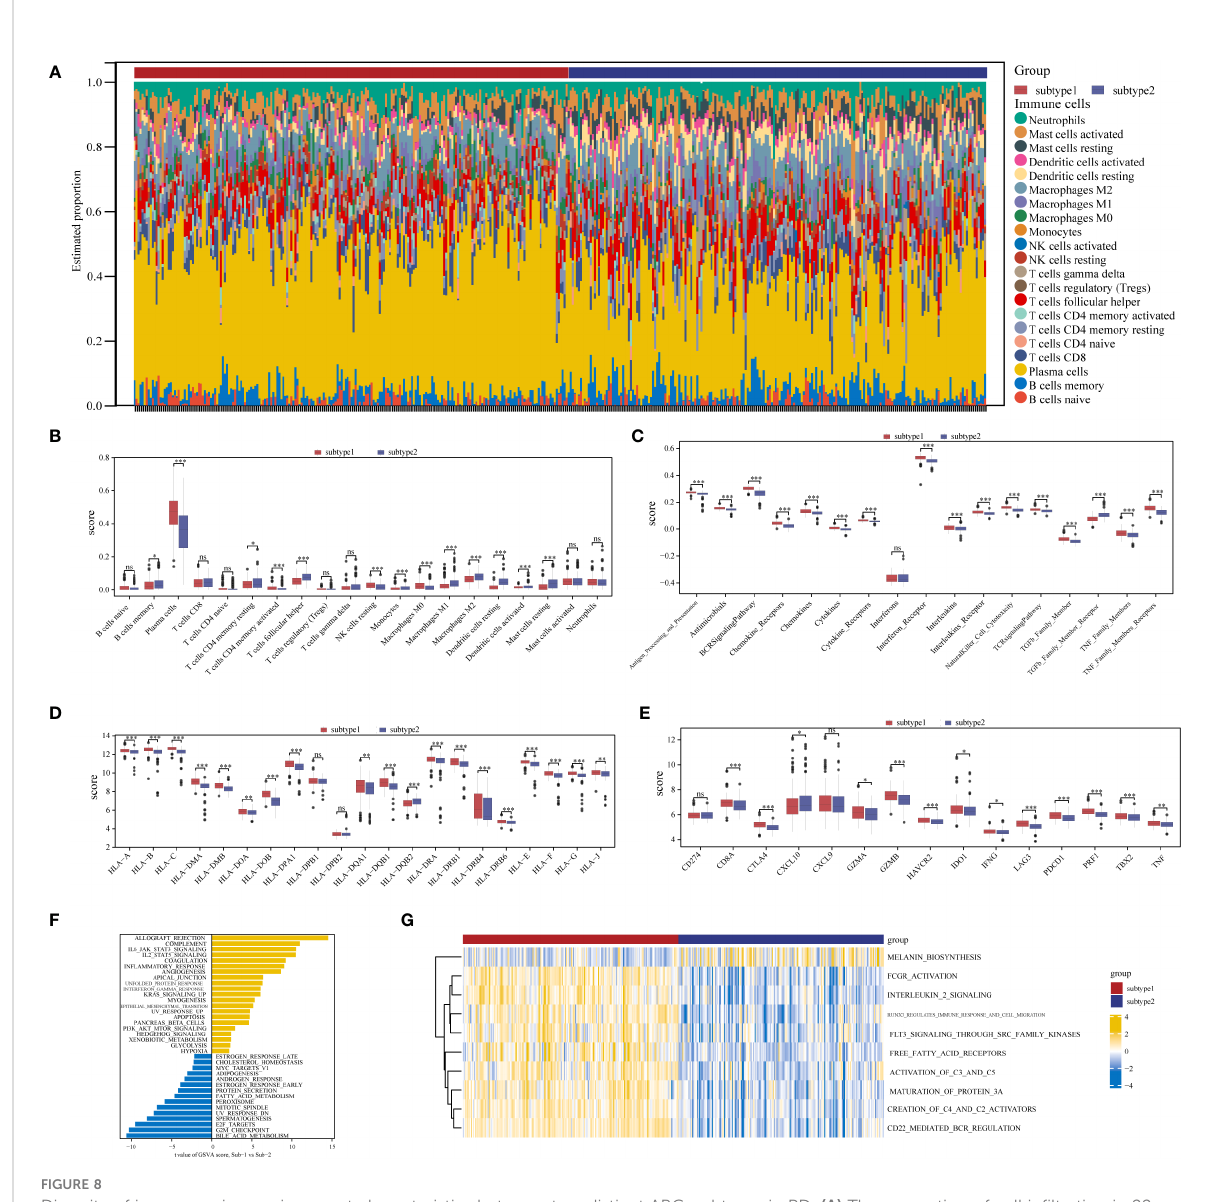
FIGURE 8 Diversity of immune microenvironment characteristics between two distinct ARG-subtypes in PD. (A) The proportion of cell in fi ltration in 22 types of immune cells in the two subtypes. (B) Box plots showing the differences in immune cell in fi ltrations in the two distinct subtypes. (C-E) The activity differences of each immune reaction gene set, the expression differences of each HLA gene, and the expression differences of each immune checkpoint in the two distinct subtypes, respectively (*p < 0.05, **p < 0.01, ***p < 0.001, and ns means not signi fi cant). (F, G) The underlying biological function characteristics diversity between the distinct subtypes, and the differences of the HALLMARKS pathway and Reactome pathway enrichment score between subtype-1 and subtype-2 ( F for the HALLMARKS pathway and G for the Reactome